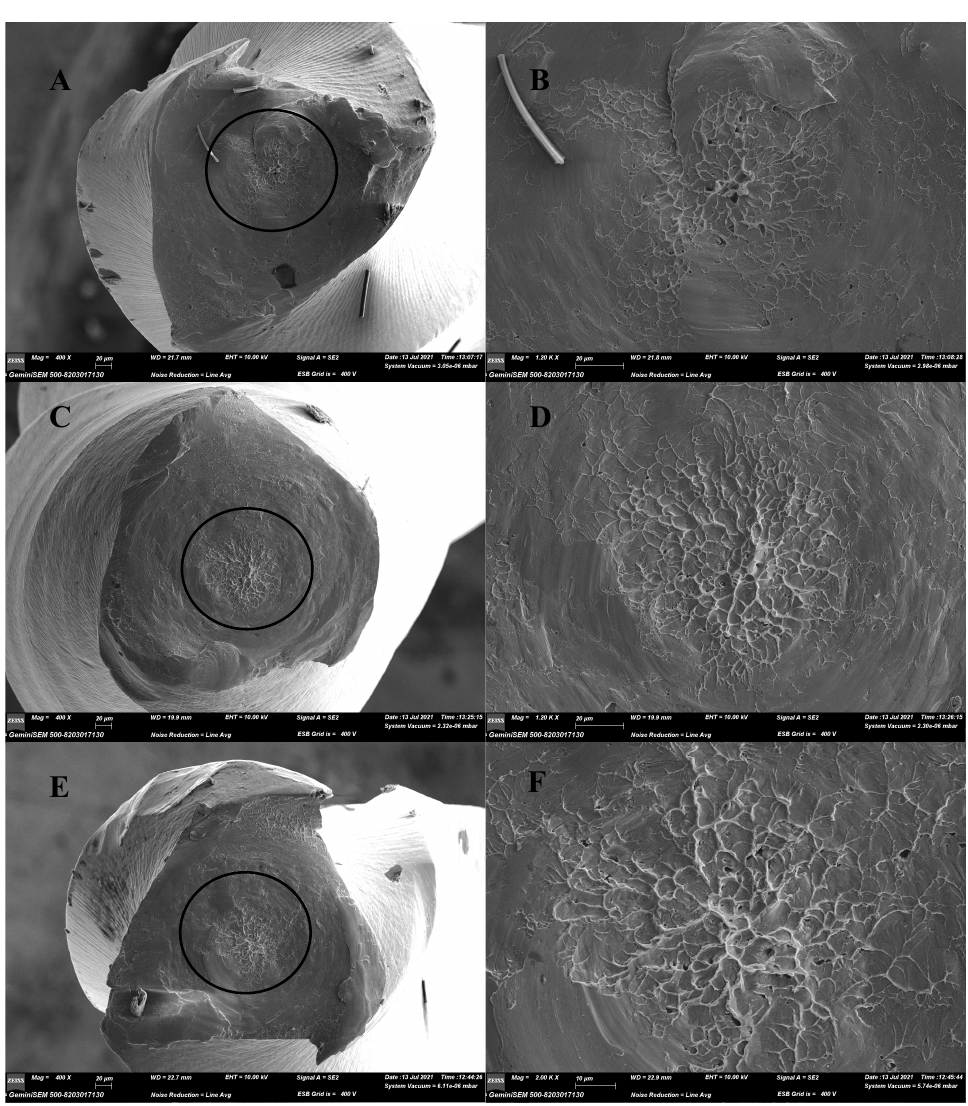
Figure 4. Scanning electron microscopic (SEM) images at lower and higher magnifications for the RACE EVO ( A , B ), R-Motion ( C , D ) and RaCe ( E , F ) instruments’ fractured surfaces after torsion tests. Relatively smooth surfaces compared to cyclic fatigue and concentric abrasion patterns were observed at low magnification ( A , C , E ). Higher magnification of the central areas indicated by circles at low magnification revealed areas with dimpled surfaces, which are characteristic of torsional fatigue ( B , D , F